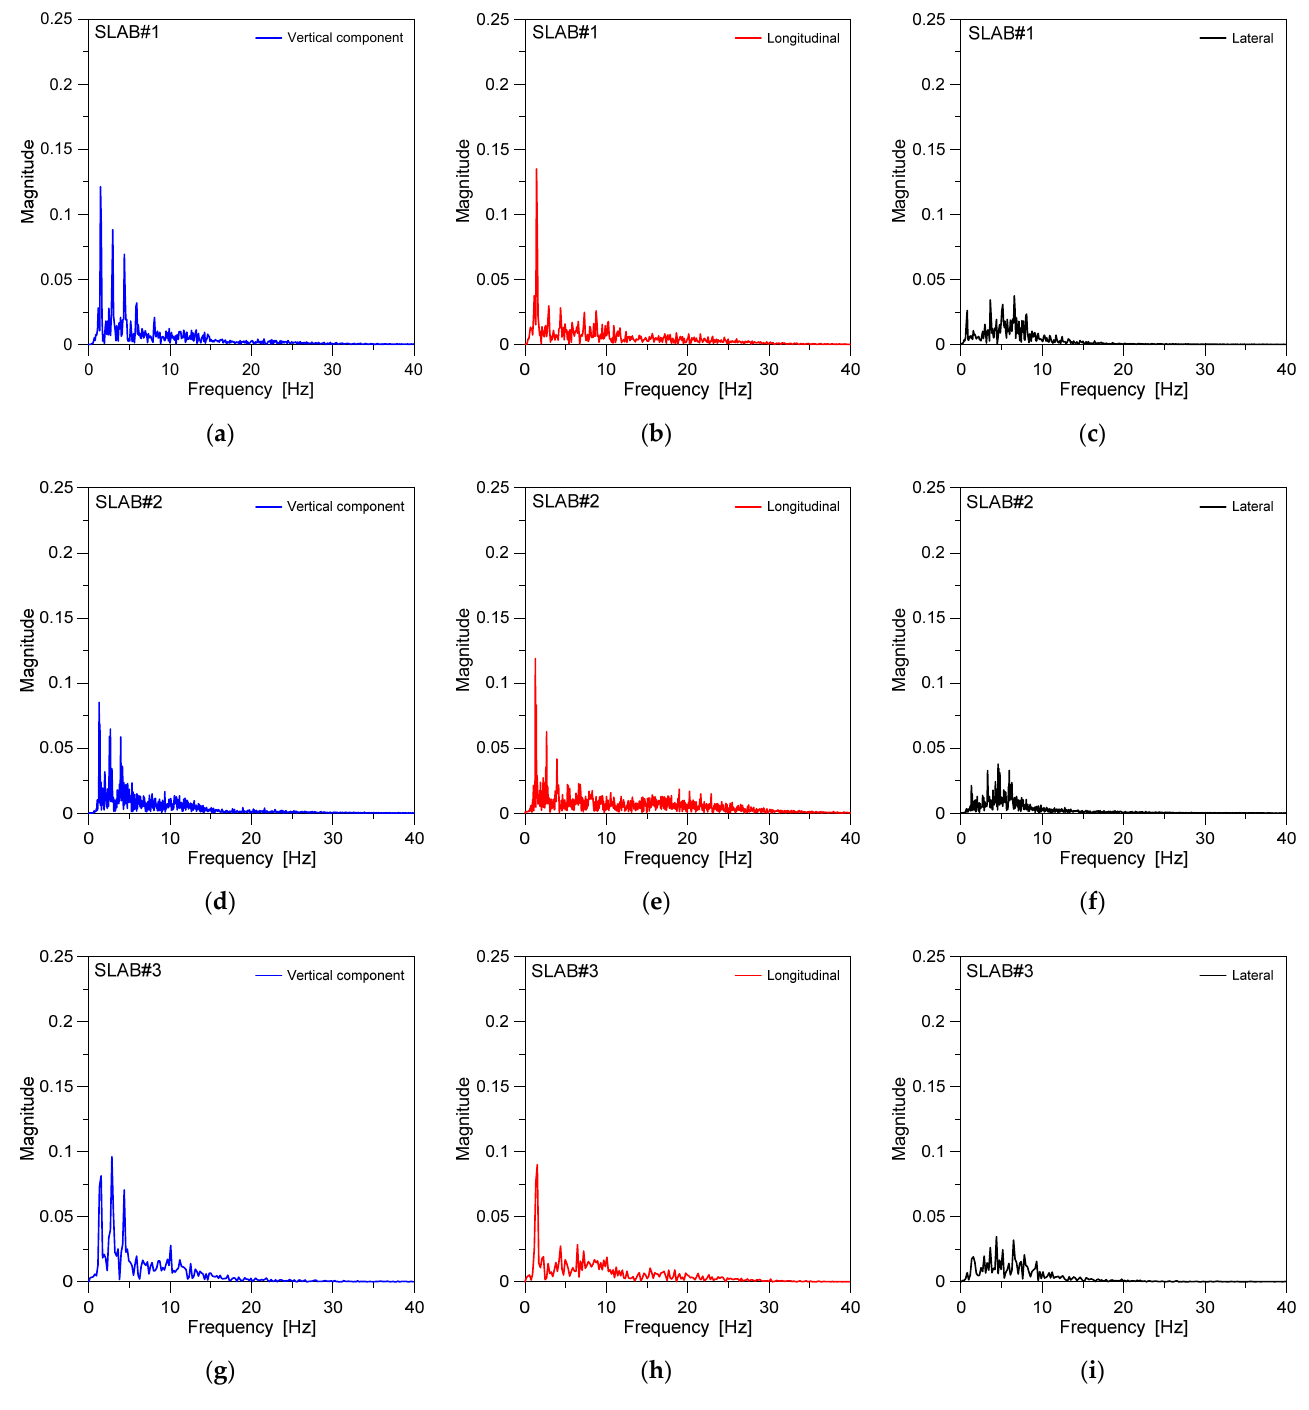
Figure 7. Examples of experimentally derived FFT spectra (normalized with respect to the weight of the pedestrian) for a single adult pedestrian under normal walks on ( a – c ) rigid (SLAB#1) or ( d – f ) flexible SLAB#2 and ( g – i ) SLAB#3 transparent floors, with evidence of ( a , d , g ) vertical, ( b , e , h ) longitudinal, and ( c , f , i ) lateral force components based on body CoM measurements of the adult volunteer under normal walking gait. Table 4. Average trend of FFT peak amplitudes, as obtained from experimental spectra (normalized with respect to the weight of pedestrian) for vertical, longitudinal, and lateral force components on different substructures.